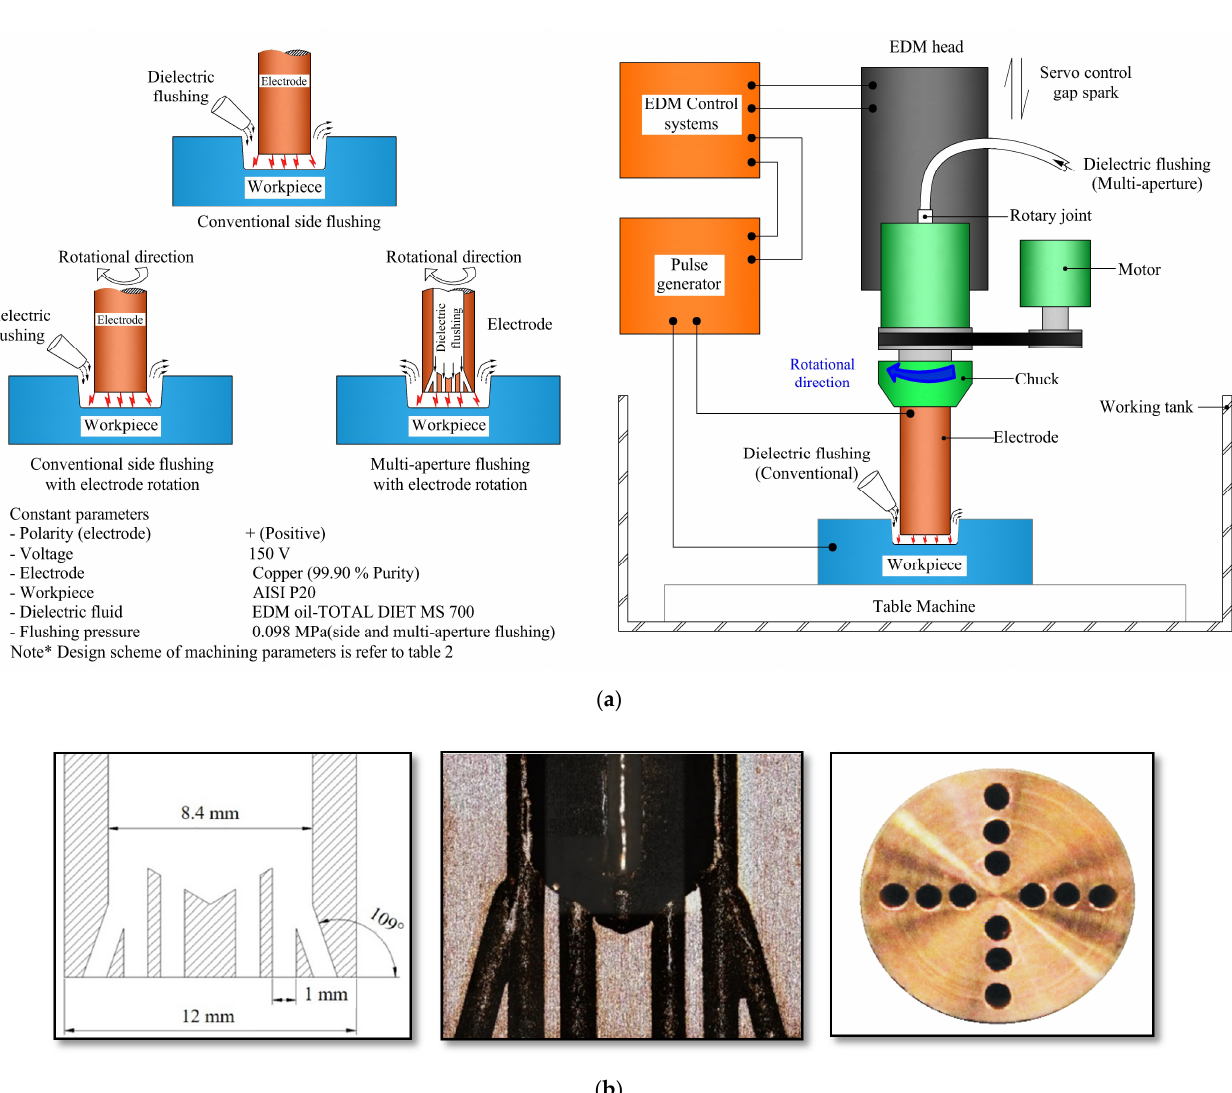
Figure 2. ( a ) Schematics of electrical discharge machining (EDM) macro deep hole experimental setup (conventional side flushing and multi-aperture flushing), ( b ) multi-aperture inner flushing copper electrode (electrode prototype).